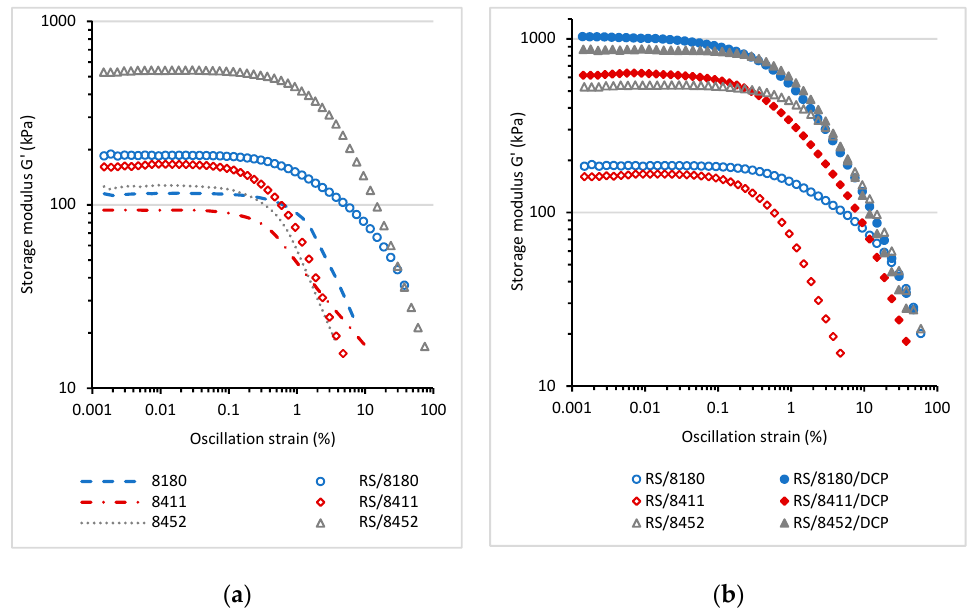
Figure 4. The storage shear modulus G ’ as a function of oscillation strain (%) for neat TPE and RS/TPE blends ( a ); for cured RS/TPE/DCP blends ( b ). Condition of measurements: angular frequency 10 rad ⋅ s − 1 , temperature 25 °C.